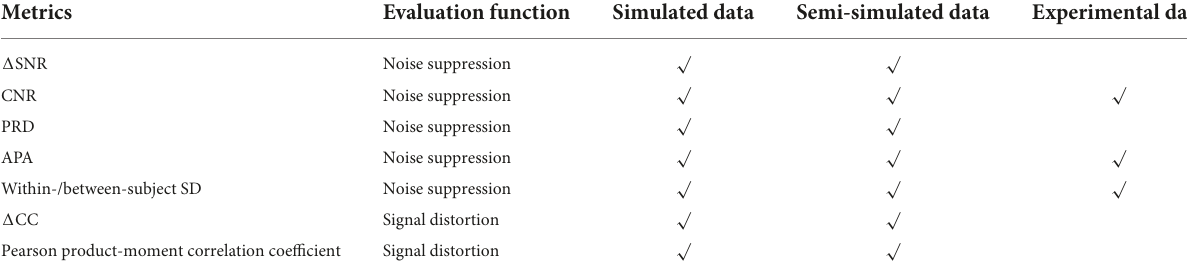
TABLE 7 Suitability checking of the defined metrics to three types of data. Metrics